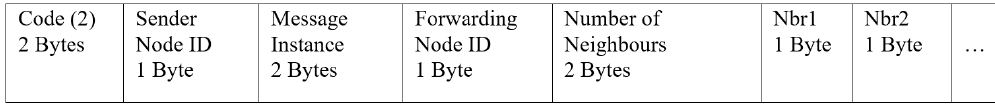
Figure 5 . Neighbor Information Packet Structure. Figure 5. Neighbor Information Packet